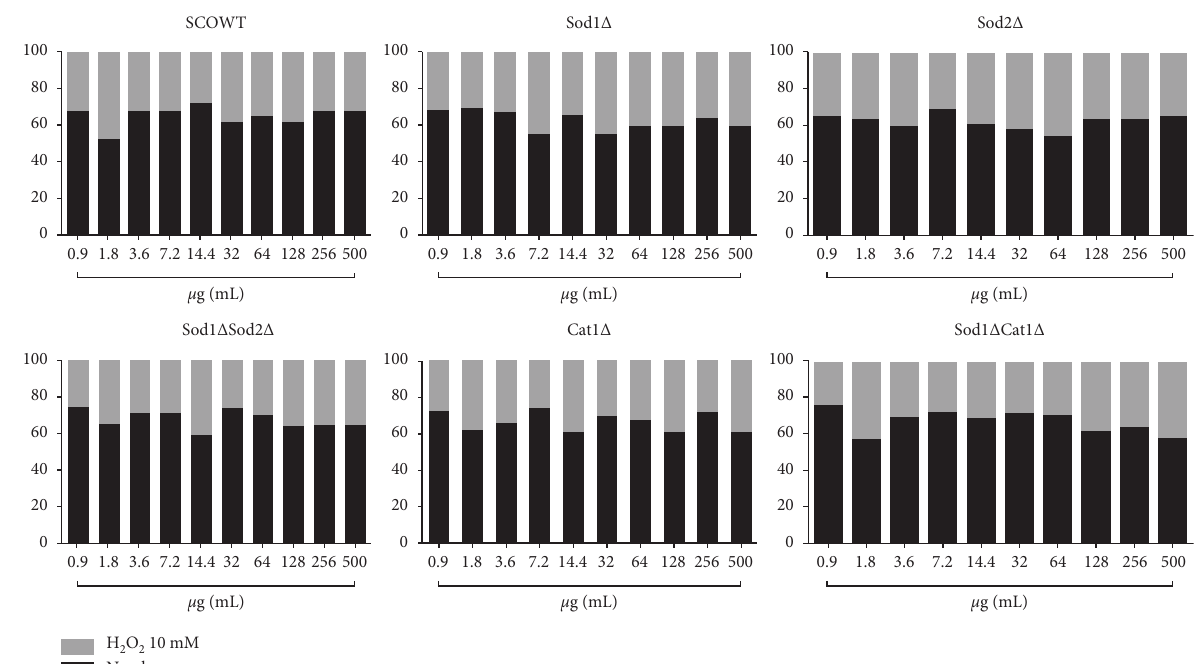
Figure 6: Modulatory efect of nerol in oxidative damage induced by hydrogen peroxide.